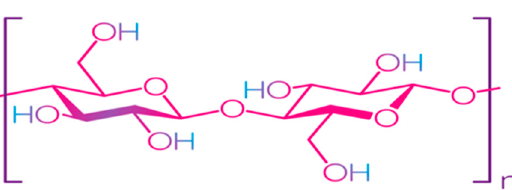
Figure 3. Structure of cellulose [49]. Reproduced with permission from Trache, D. et al., International Journal of Biological Macromolecules; published by Elsevier Ltd., 2016.